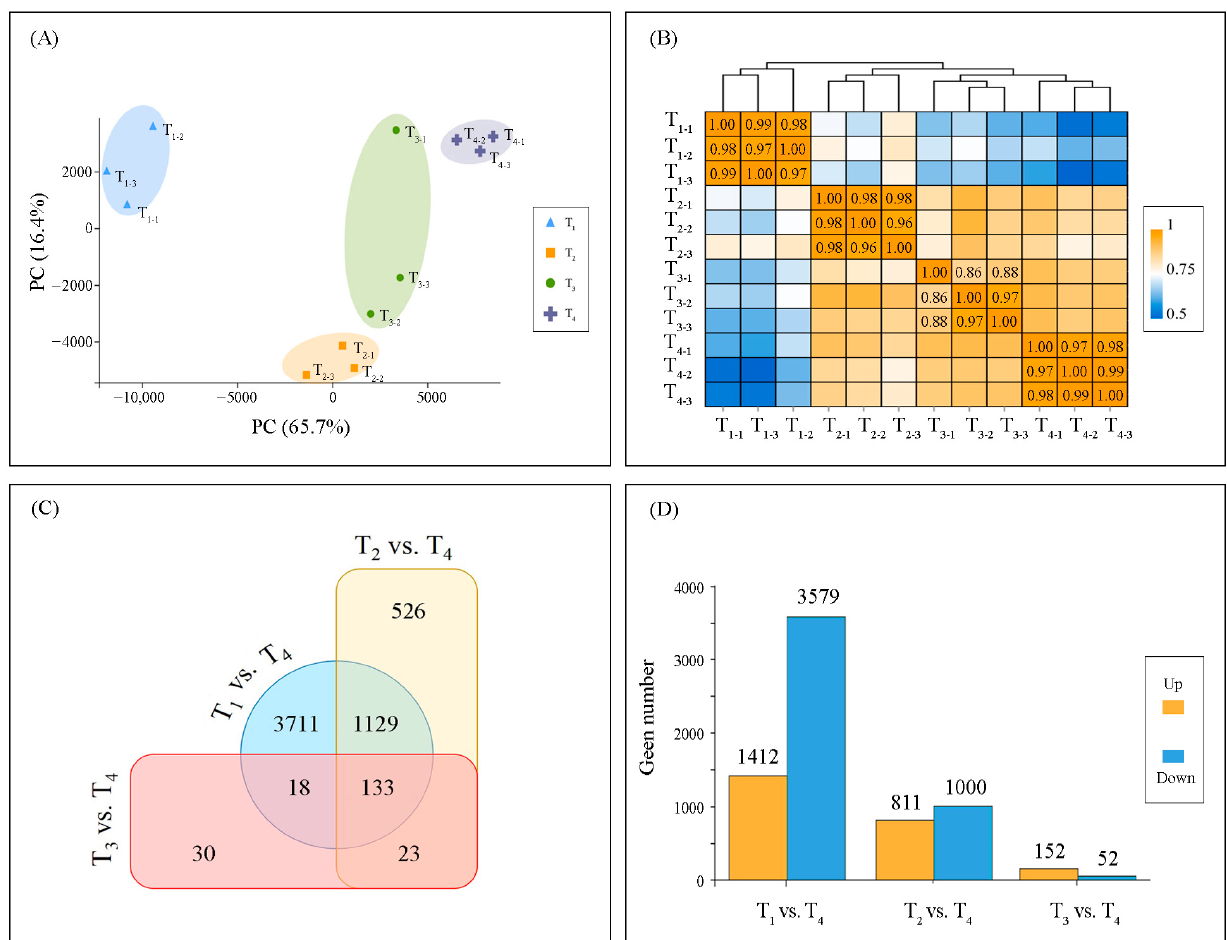
Figure 4. Variation in transcriptional levels in the ginkgo leaf different developmental stages (T 1 –T 4 ). ( A ) PCA plots with each point representing an independent biological replicate; ( B ) Pearson product-moment correlation coefficients and clusters of the gene expression profile from leaf samples (the more orange the rectangle, the stronger the correlation between the samples, whereas the bluer the rectangle, the weaker the correlation); Taking T 4 sample as reference, the number of differentially expressed genes (DEGs) between samples at the four development stages is depicted on Venn diagram ( C ) and column chart ( D , yellow and blue represent up- and down-gene expression, respectively).